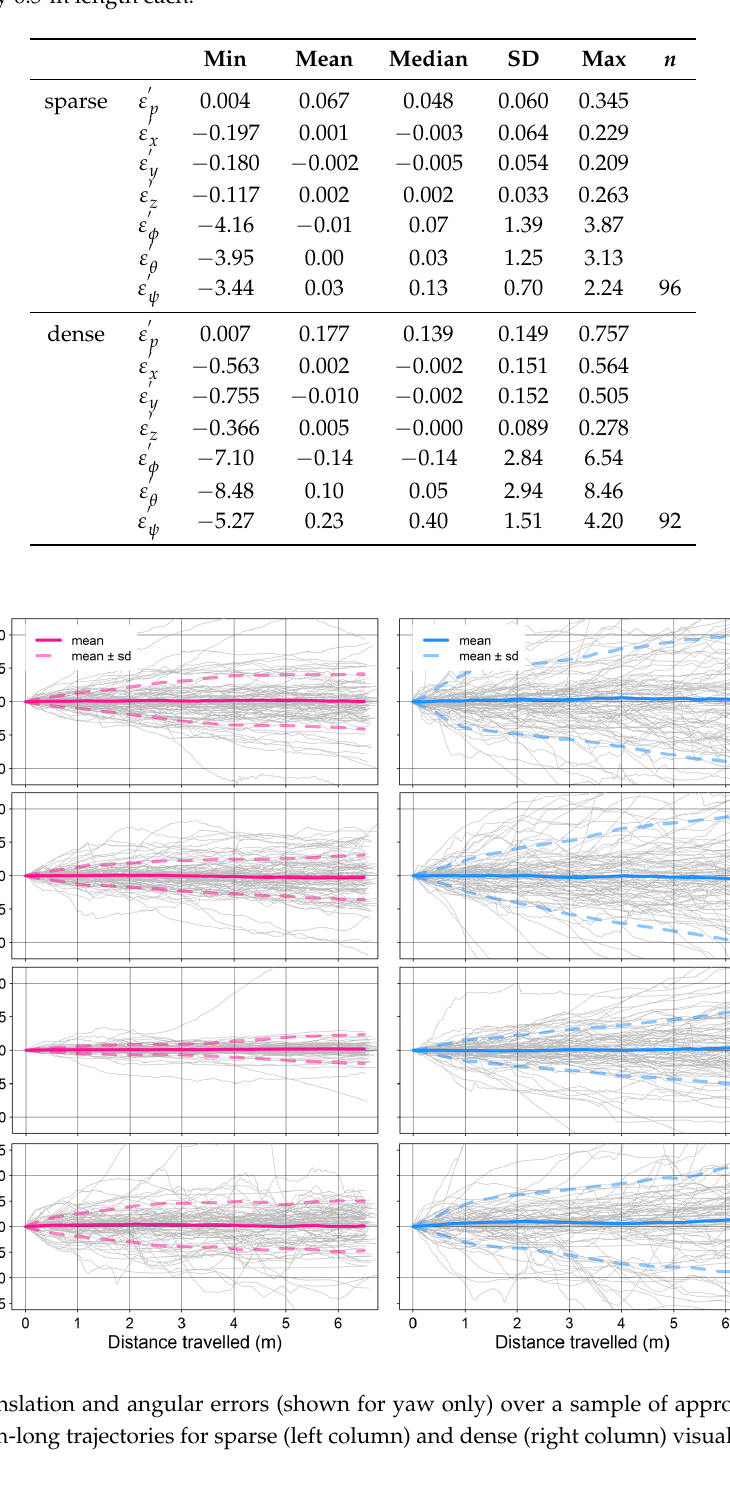
Table 1. 3D position and translation error over displacement (in m · m − 1 ) and angular errors over displacement (deg · m − 1 ) for sparse and dense visual odometry, computed from n sections of an approximately 6.5-m length each.